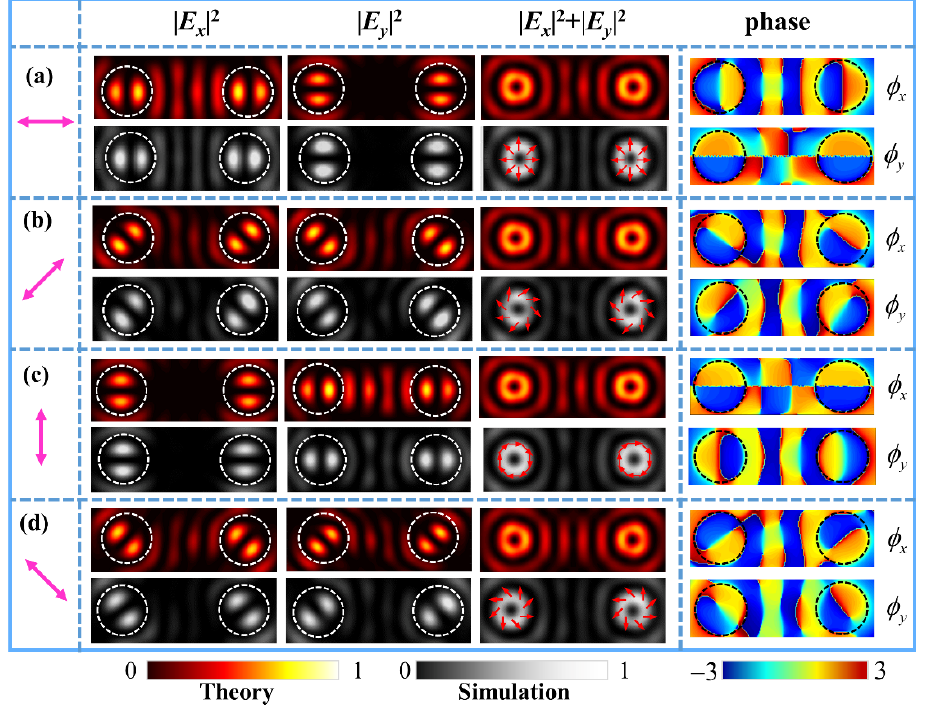
Figure 2. Theoretical and simulated results of the same FVBs of orders l l = l r = 1 and the corresponding simulated phase distributions of x - and y -components in the dual channels in the observation plane under the illumination of linearly polarized light with polarization angles at ( a ) α = 0°, ( b ) α = 45°, ( c ) α = 90°, and ( d ) α = 135°, respectively. The purple double arrows indicate the polarization direction of the incident light. The arrows on the simulated intensity patterns in the right column schematically show the polarization distributions of the VBs.